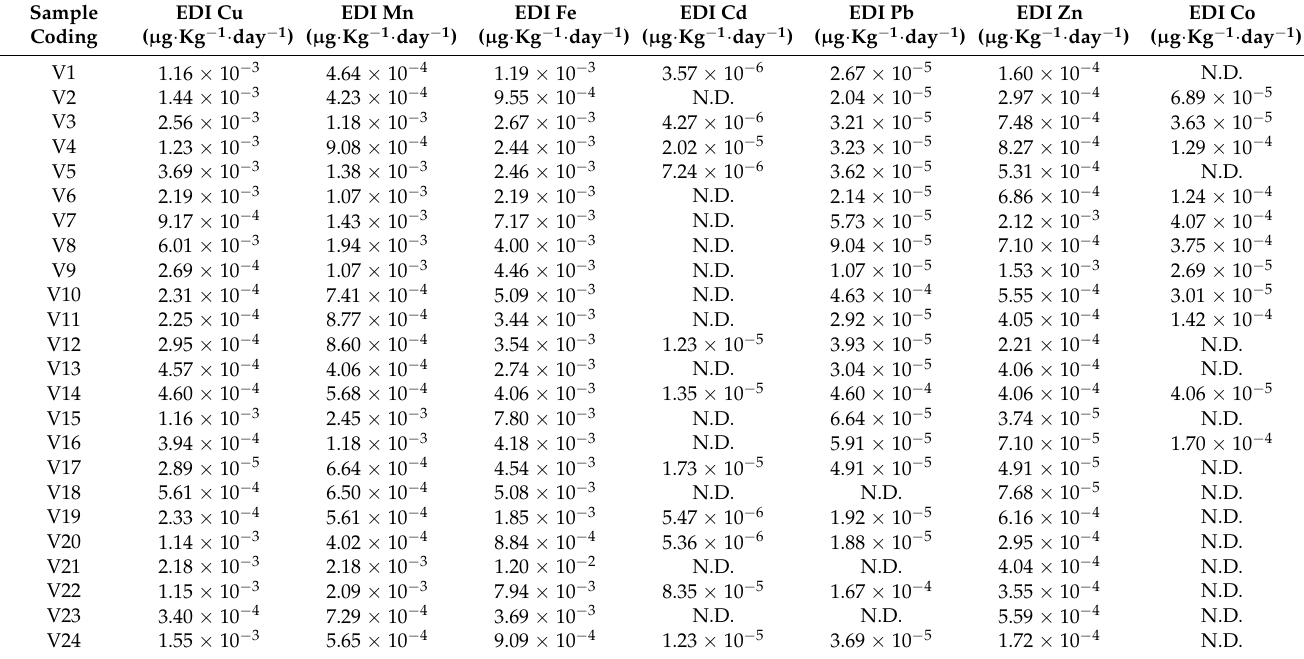
Table 3. Obtained results for the estimated daily intake (EDI) in the case of vegetable samples.